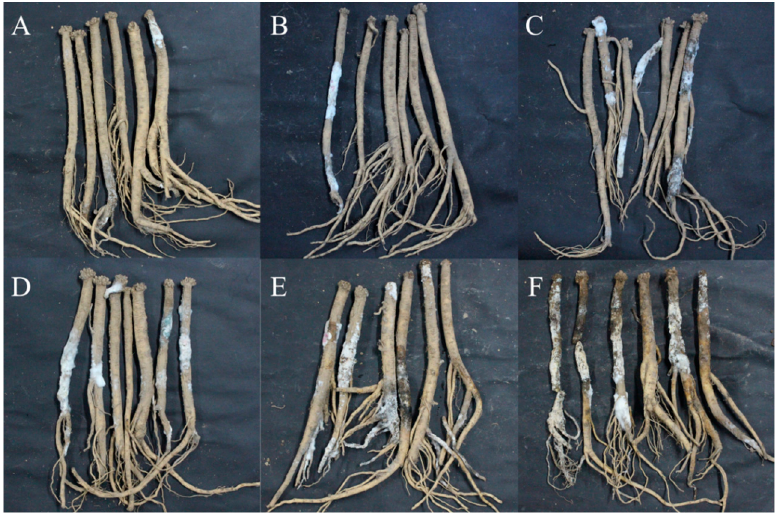
Figure 1. Disease development and naturally occurring symptoms of the fresh C. pilosula during different storage stages after harvest. ( A ): 7 d; ( B ): 14 d; ( C ): 21 d; ( D ): 28 d; ( E ): 42 d; ( F ): 56 d.